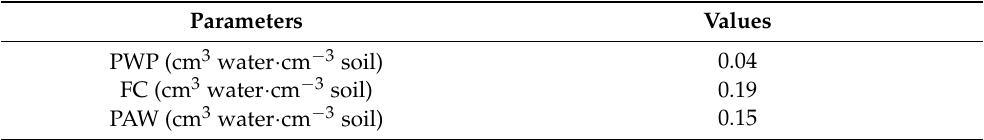
Table 2. Soil hydraulic properties. Permanent wilting point, PWP; field capacity, FC; and plant available water, PAW. Given are mean ( n =